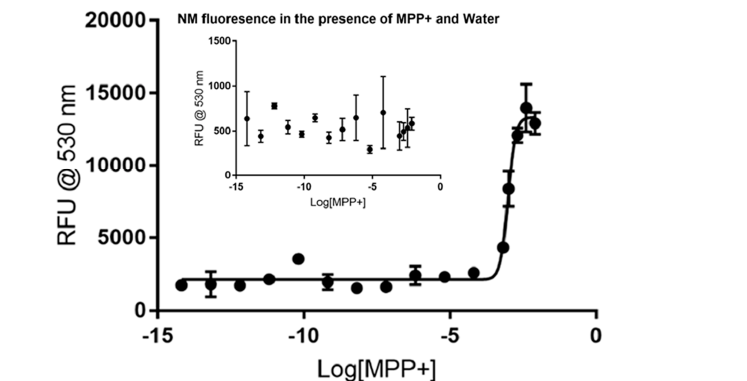
Figure 1. Fluorescence of synthetic neuromelanin (NM; sometimes written as NM-Fe to indicate its iron-bound state) upon exposure to 1-methyl-4-phenylpyridinium ion (MPP + ) in the absence (inset) and presence of nicotine as a signal molecule. MPP + does not itself appear to induce a stable fluor signal in solutions of NM-Fe as judged by the high variability and low average RFU counts of quadruplicate measurements (inset). On the inclusion of nicotine however, an enhanced signal appears to stabilize slightly, with a sharp inflection evident near 10 − 3 M MPP + concentrations (K d ~1 mM). A second, smaller inflection was consistently evident in repeat experiments as seen by the hump near 10 − 11 M, suggestive of a second saturable binding interaction at much lower